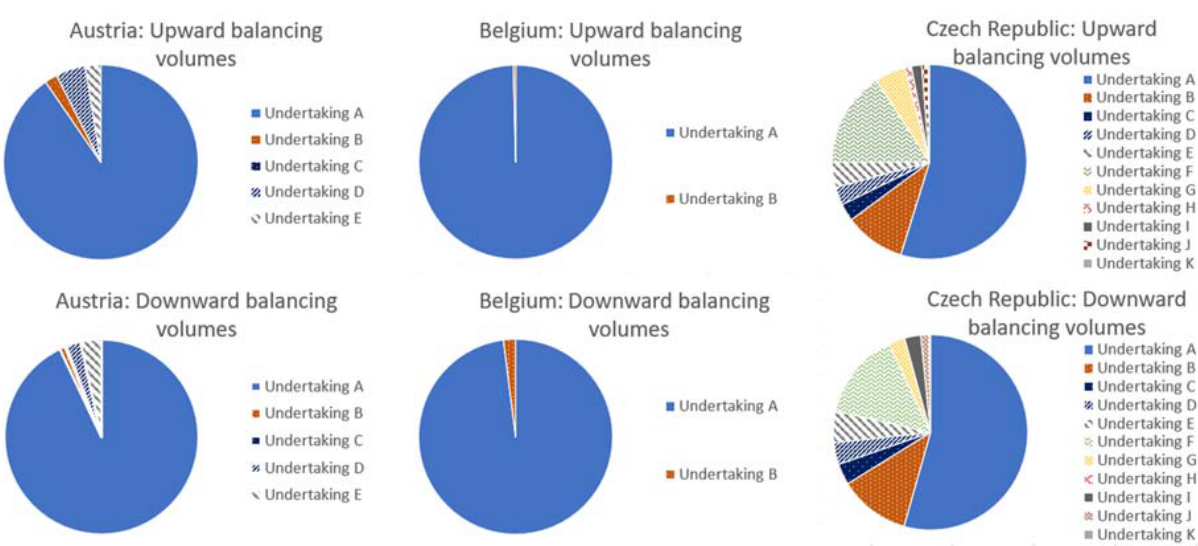
Figure 2. The volumes supplied (MWh) by generators aggregating secondary and tertiary reserves between January 2003 and January 2005. Adapted from [24].